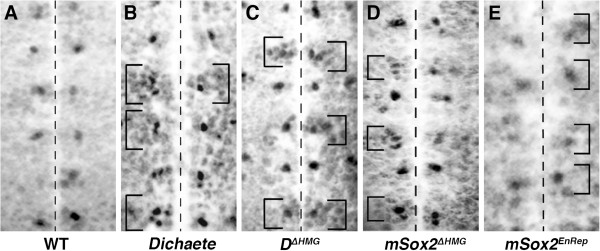
Proneural gene expression.  Ventral views of the medial and intermediate columns of the stage 11 embryonic neuroectoderm stained with anti-Achaete, anterior is to the top. The ventral midline is indicated by the dashed line and neuromeres in individual hemisegments indicated by brackets. A) Wild type; B) Dr72/Df(3L)fz-GS1a; C) pros-GAL4; UAS-DΔHMG; D) pros-GAL4; UAS-Sox2ΔHMG; E) pros-GAL4; UAS-Sox2EnRep
.